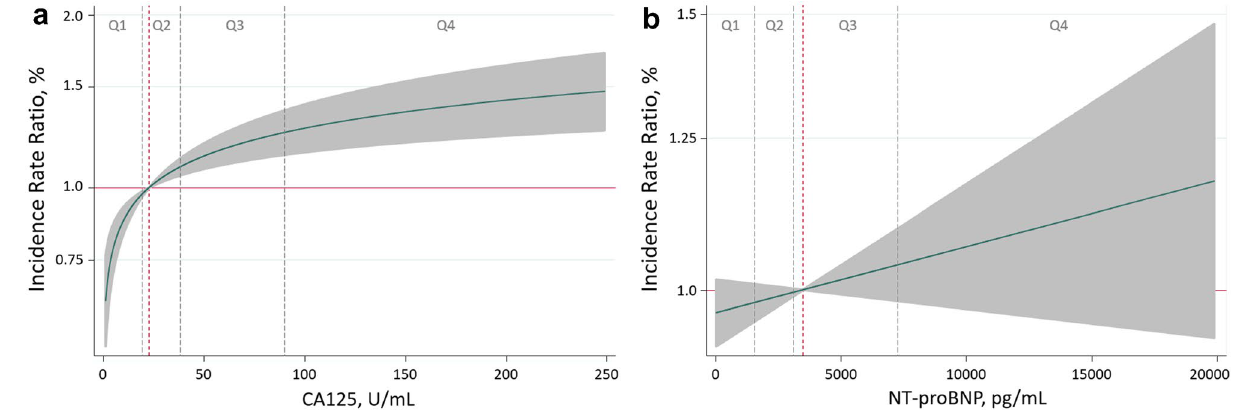
Figure 1. Functional form of the risk of AHF recurrent hospitalizations among the continuum of CA125 and NT-proBNP values. ( a ) CA125. ( b ) NT-proBNP. AHF: acute heart failure; CA125: carbohydrate antigen 125; NT-proBNP: amino-terminal pro-brain natriuretic peptide. CA125 quartiles: Q1 = 1.4–19 U/mL; Q2 = 19–38.26 U/mL; Q3 = 38.3–90 U/mL; Q4 = 90–1500